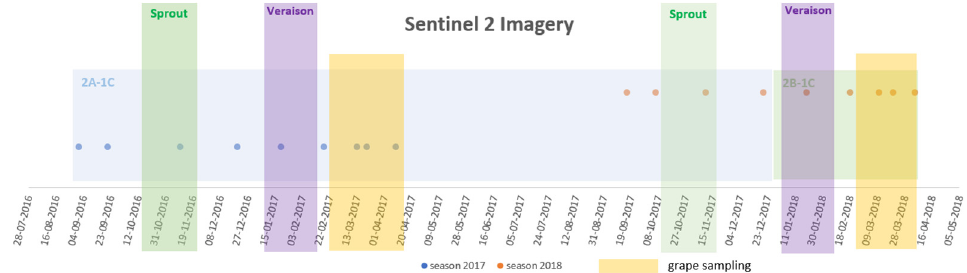
Figure 3. Acquisition dates of the Sentinel-2 images used to characterize the vegetative behavior of the vine in both seasons, from bud break (September) to harvest (April). The sprouting, veraison stage, and the dates for fruit sampling in the field in both seasons are also shown.